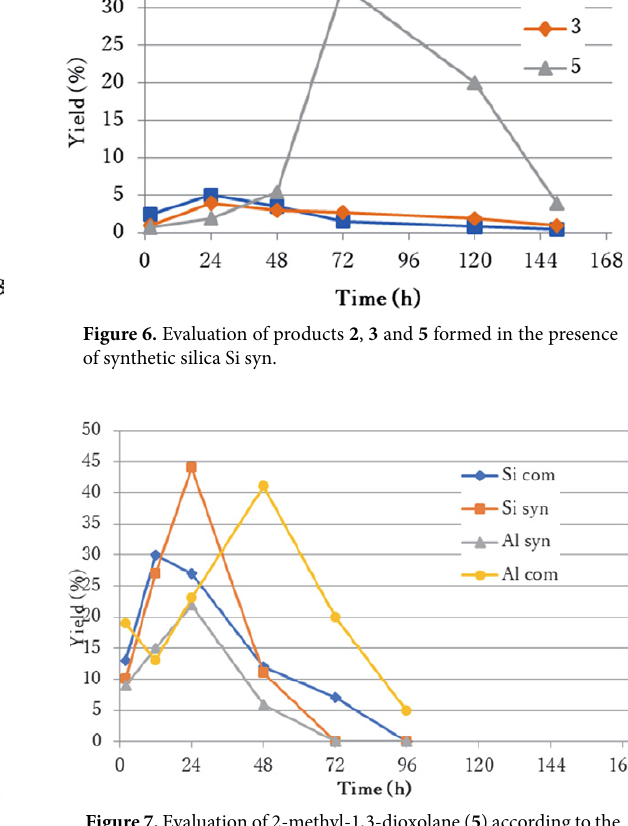
Figure 7. Evaluation of 2-methyl-1,3-dioxolane ( 5 ) according to the nature of the catalyst and the reaction